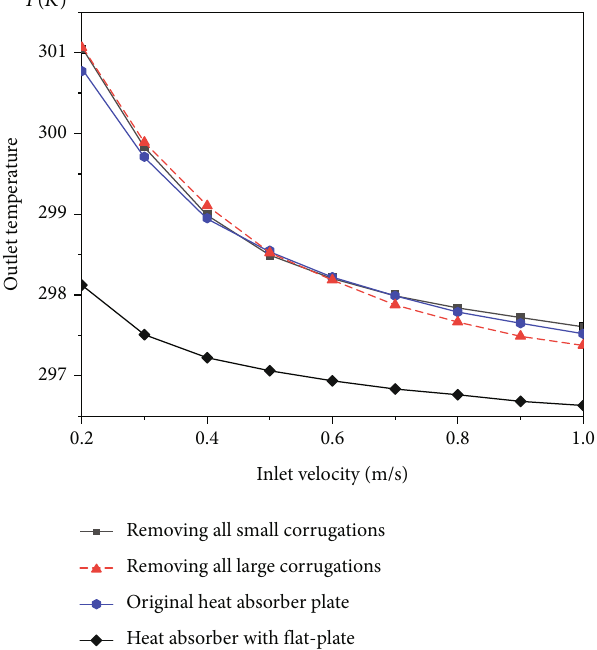
Figure 11: Outlet temperature comparison of three types of absorber plates after changing the corrugation